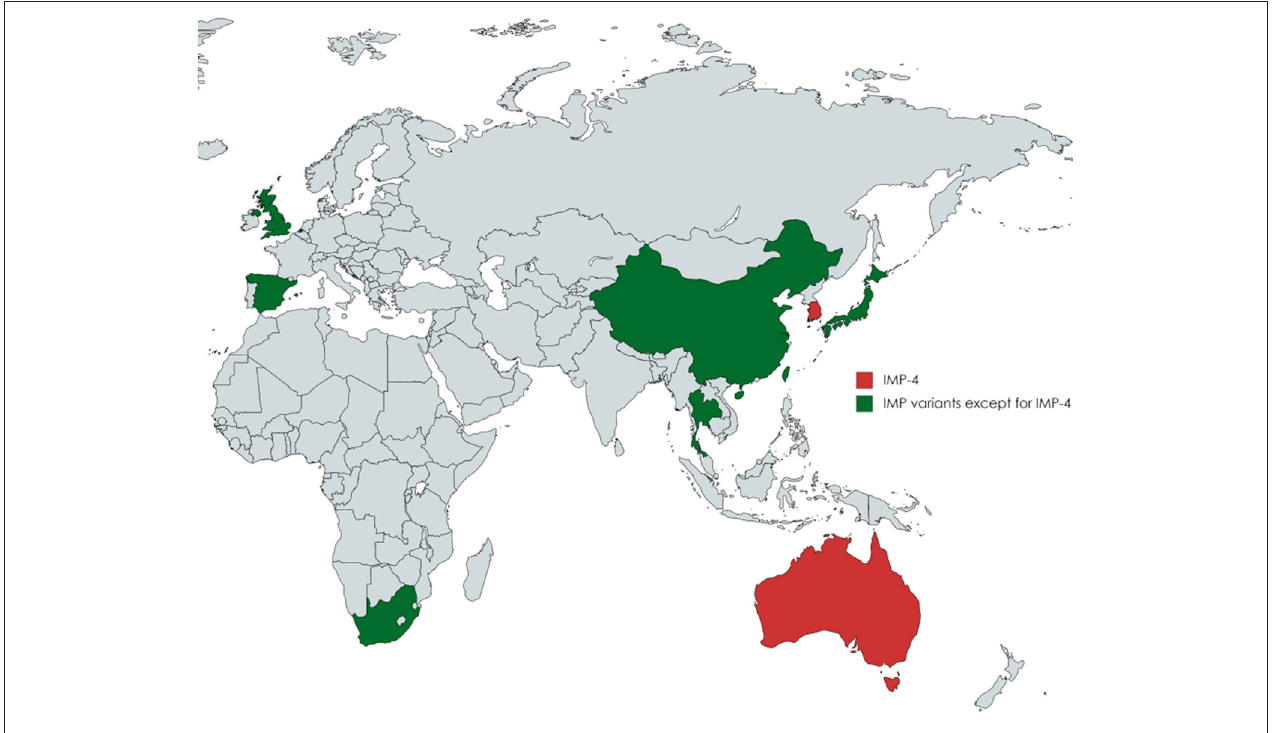
FIGURE 1 | A map showing the global distribution of IMP-producing Enterobacter cloacae isolates . IMP-4-producing E. cloacae strains were especially described in Australia and Korea. IMP-type except for IMP-4 E. cloacae isolates have been reported in Taiwan (IMP-8), China (IMP-1 and IMP-34), Thailand (IMP-14), Japan (IMP-1 and IMP-11), Spain (IMP-13), United Kingdom (IMP-1), and South